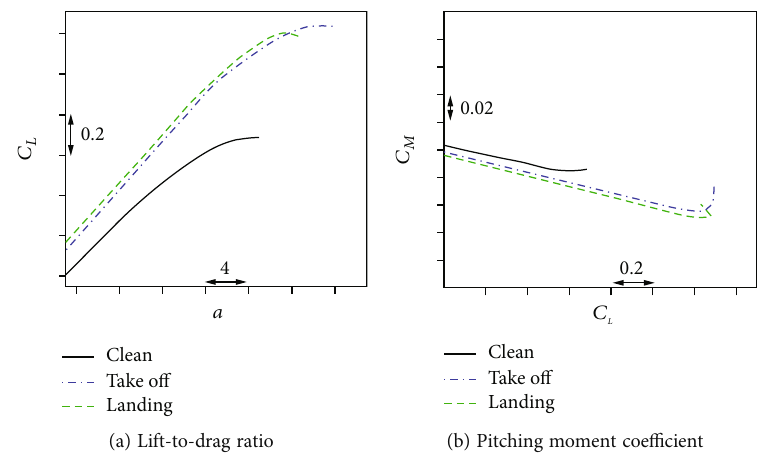
Figure 24: Aerodynamic performance compared with SWB-2 WC and HL at take-o ff speed.